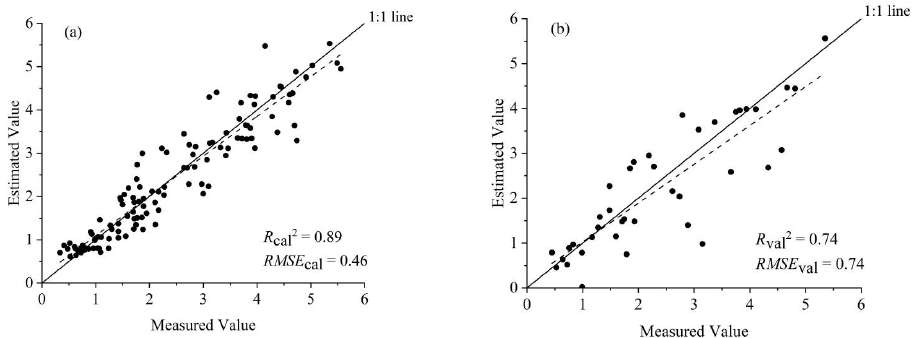
Figure 7. Results for the ANN model. ( a ) Calibration; ( b ) Validation.